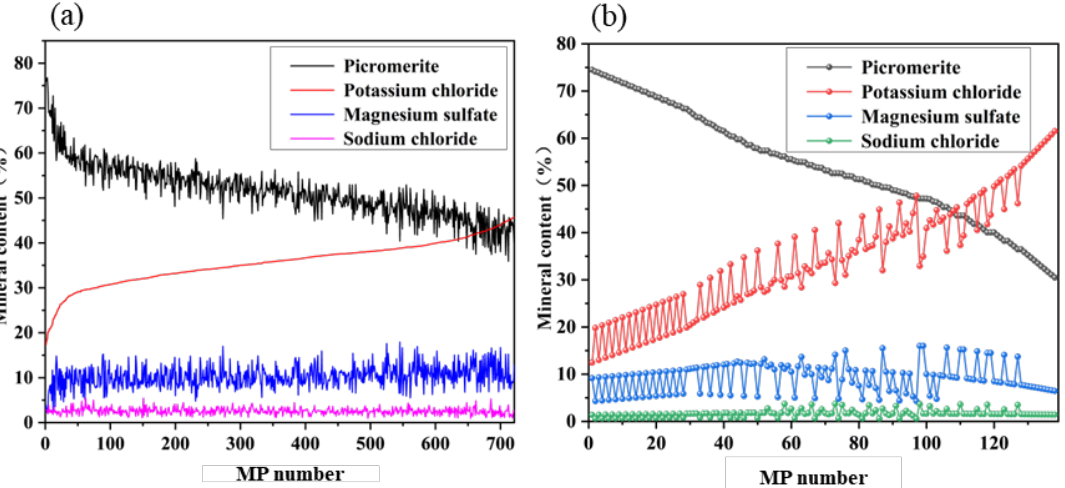
Figure 4. ( a ) Mineral composition of 738 MP samples from the production site. Mineral ( b ) compo- sition of 138 MP samples designed and